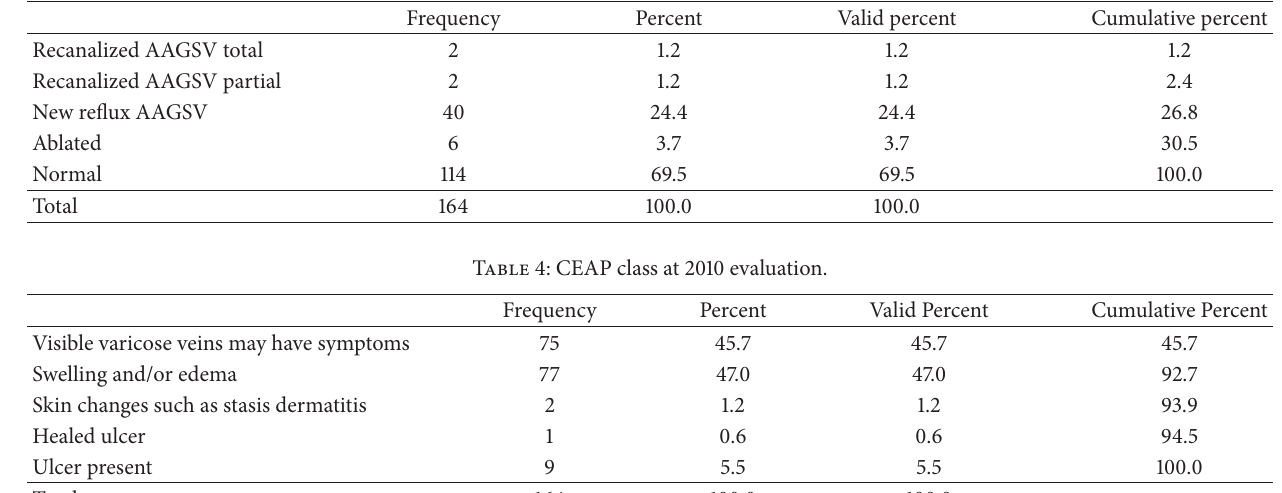
Table 3: Repeat US AAGSV.